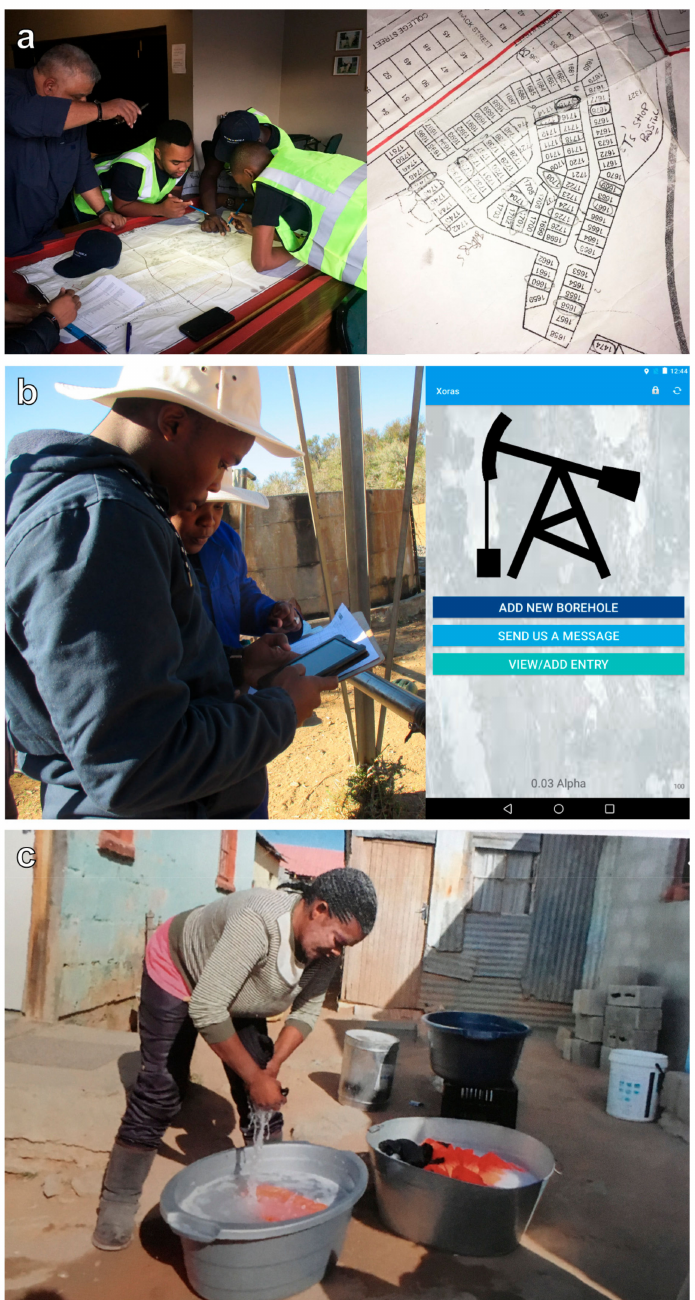
Figure 13. Citizen Science and household surveys in Karoo communities: ( a ) AEON researcher studying maps with fieldworkers of the housing department and a human settlement map in Jansenville; ( b ) hydrocensus trainees at a borehole site and the Xoras App interface; and ( c ) washing clothes using bucket systems in Lingilihle Township near Cradock. See Figure 1 for